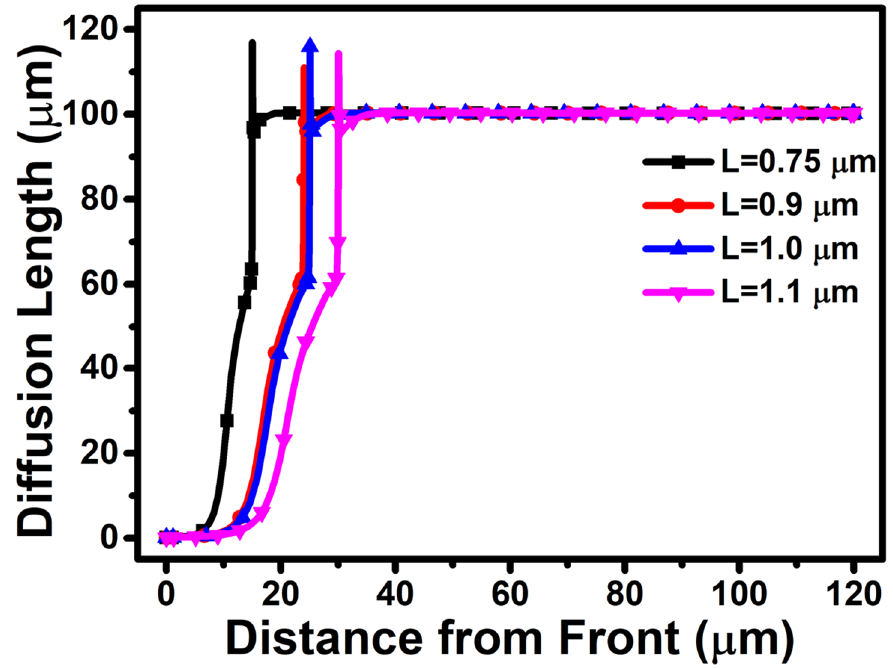
Figure 9. Influence of variation in the length of ZnO NRs AR on diffusion length.